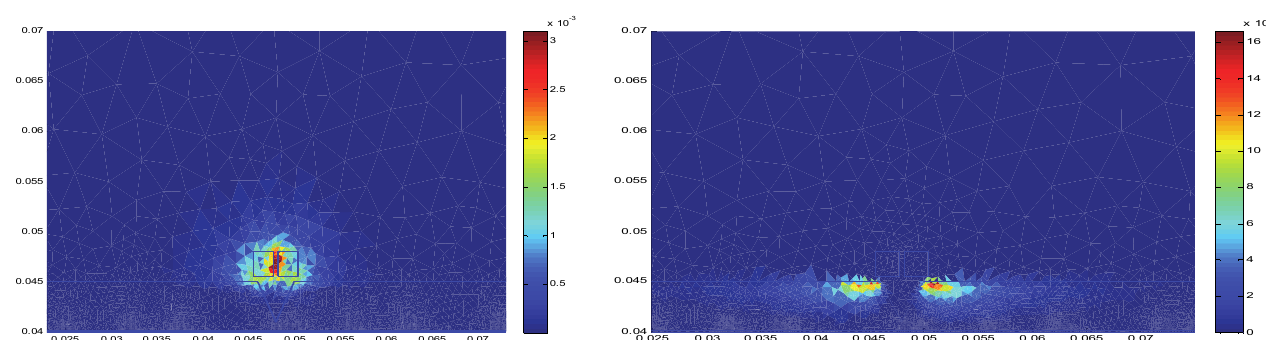
Figure 6: Representation of the magnetic induction. Figure 7: Density of induced currents.